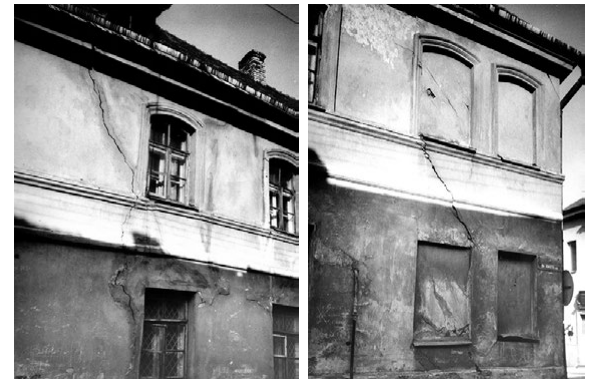
Fig. 1. Cracked walls indicate unequal settlements and limit to base